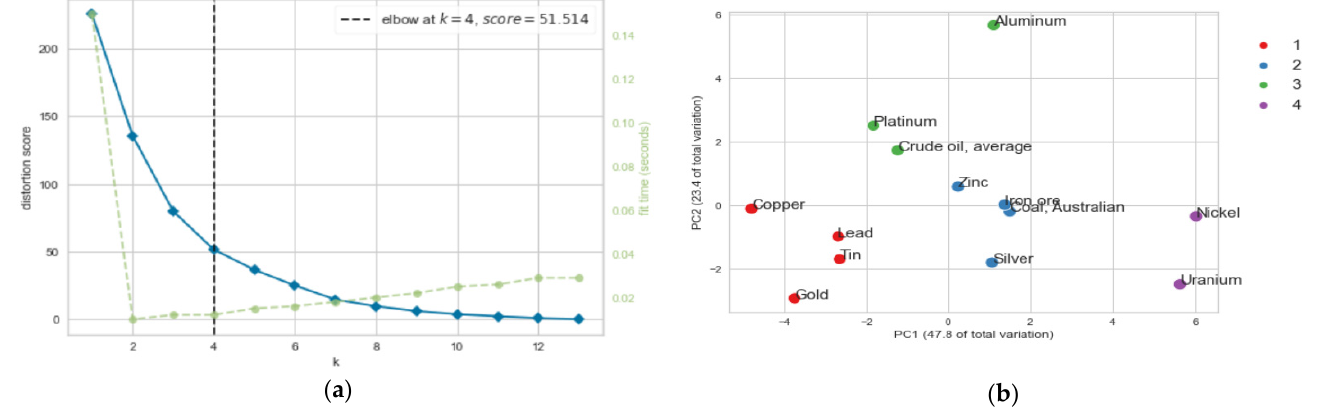
Figure 2. Distortion score for different numbers of k ( a ) and K-means clusters plotted against the first two PCs ( b ).